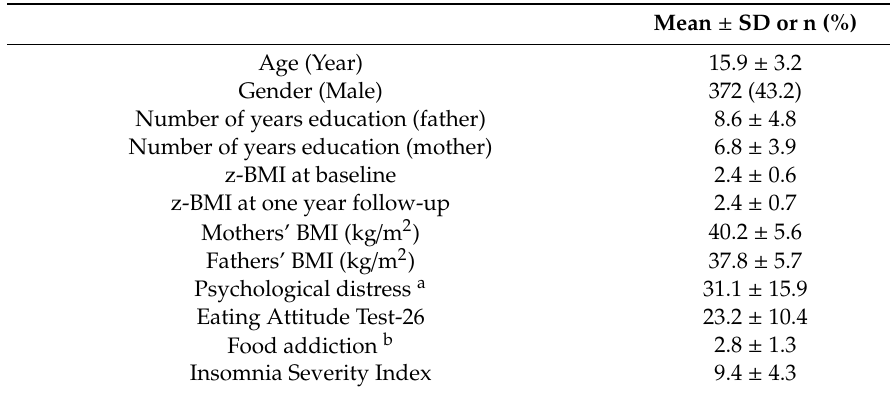
Table 1. Characteristics of the study participants (N =